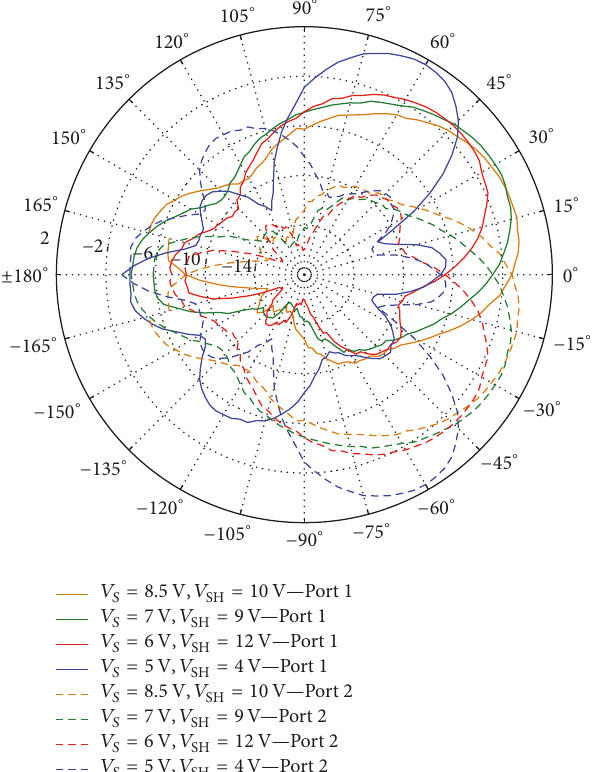
Figure 11: Azimuth (𝑥 - 𝑧) view of the total beam steering capabilities. The solid lines depict beams generated by exciting port 1 (and port 2 terminated to a 50 Ω load), whereas the dashed lines depict beams generated by exciting port 2 (and port 1 terminated to a 50 Ω load).